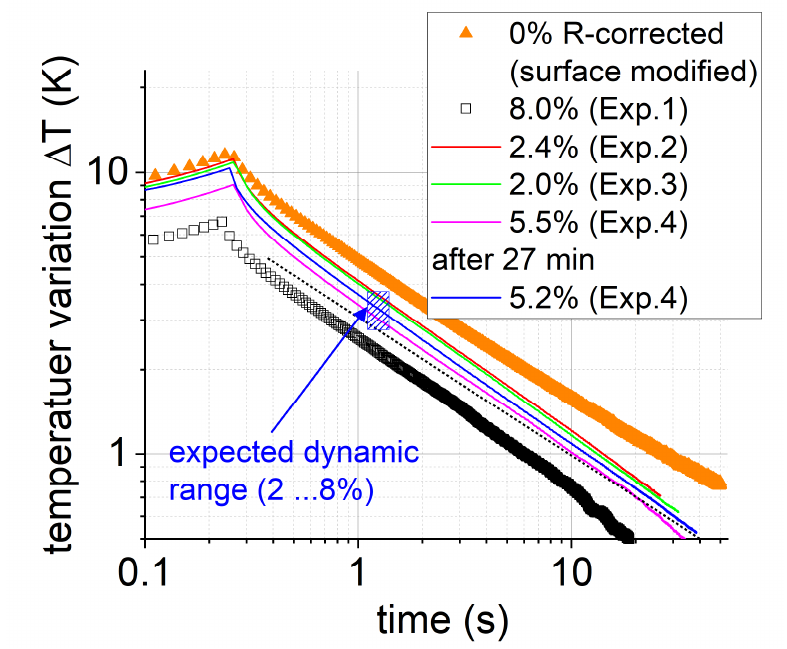
Figure 18. Same data as in Figure 17 as a log–log plot. The dotted line represents a curve according to Equation (1); the height of the blue striped rectangle indicates the expected moisture influence. Temperature transients from the formwork side of the type 1 and type 3 samples are displayed in Figures 19 and 20, respectively, showing the same effects in principle.